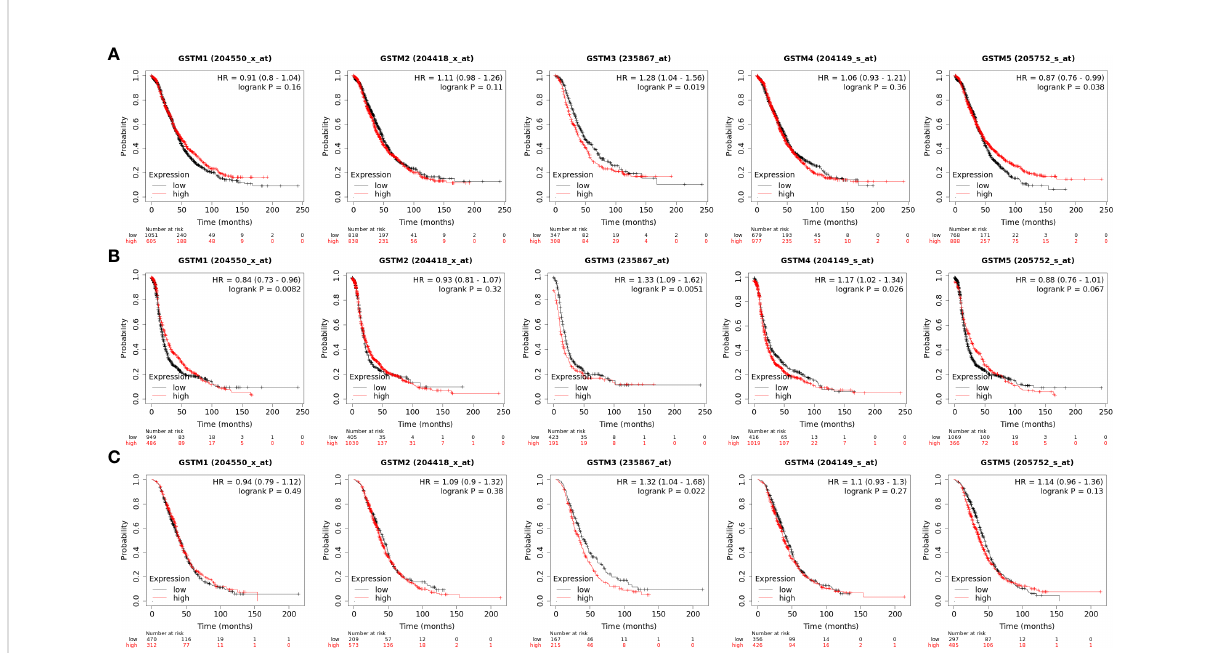
FIGURE 5 The prognosis signi fi cance of GSTM1-5 in OC. (A) The OS analysis of GSTM1/2/3/4/5 in OC dataset based on the Kaplan – Meier Plotter database. (B) The PFS analysis of GSTM1/2/3/4/5 in OC dataset based on the Kaplan – Meier Plotter database. (C) The PPS analysis of GSTM1/2/3/4/5 in OC dataset based on the Kaplan – Meier Plotter